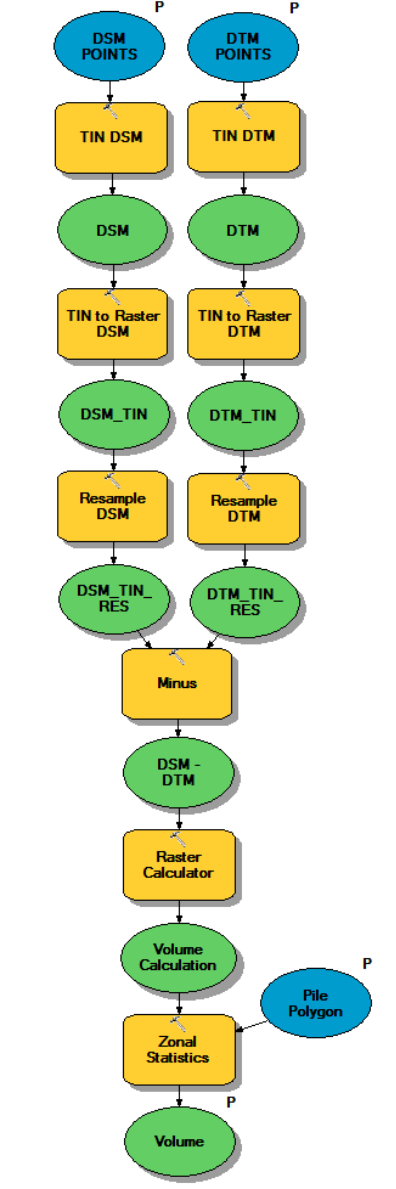
Figure 4. ArcGIS workflow for volume